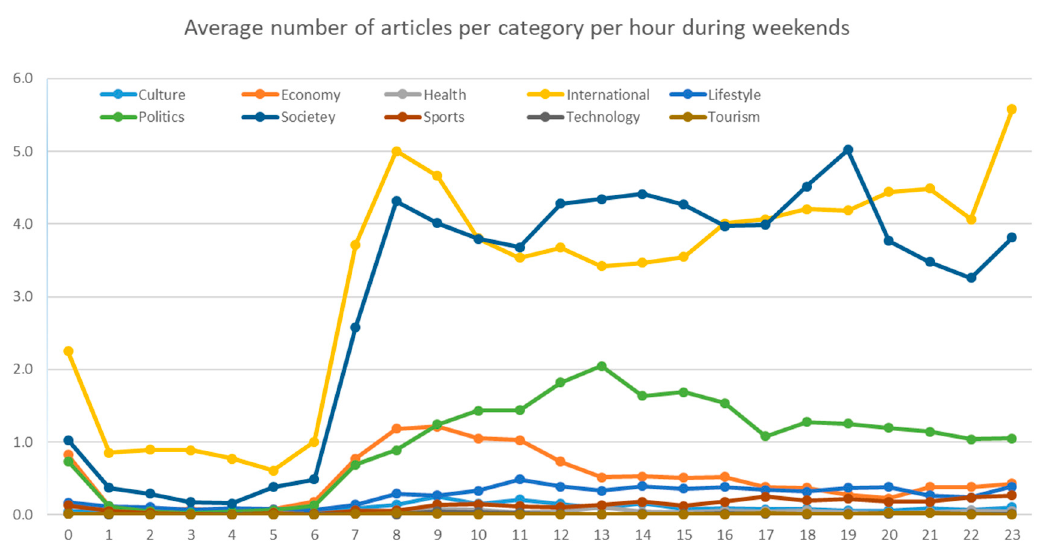
Figure 8. Average number of articles per category per hour during weekdays.